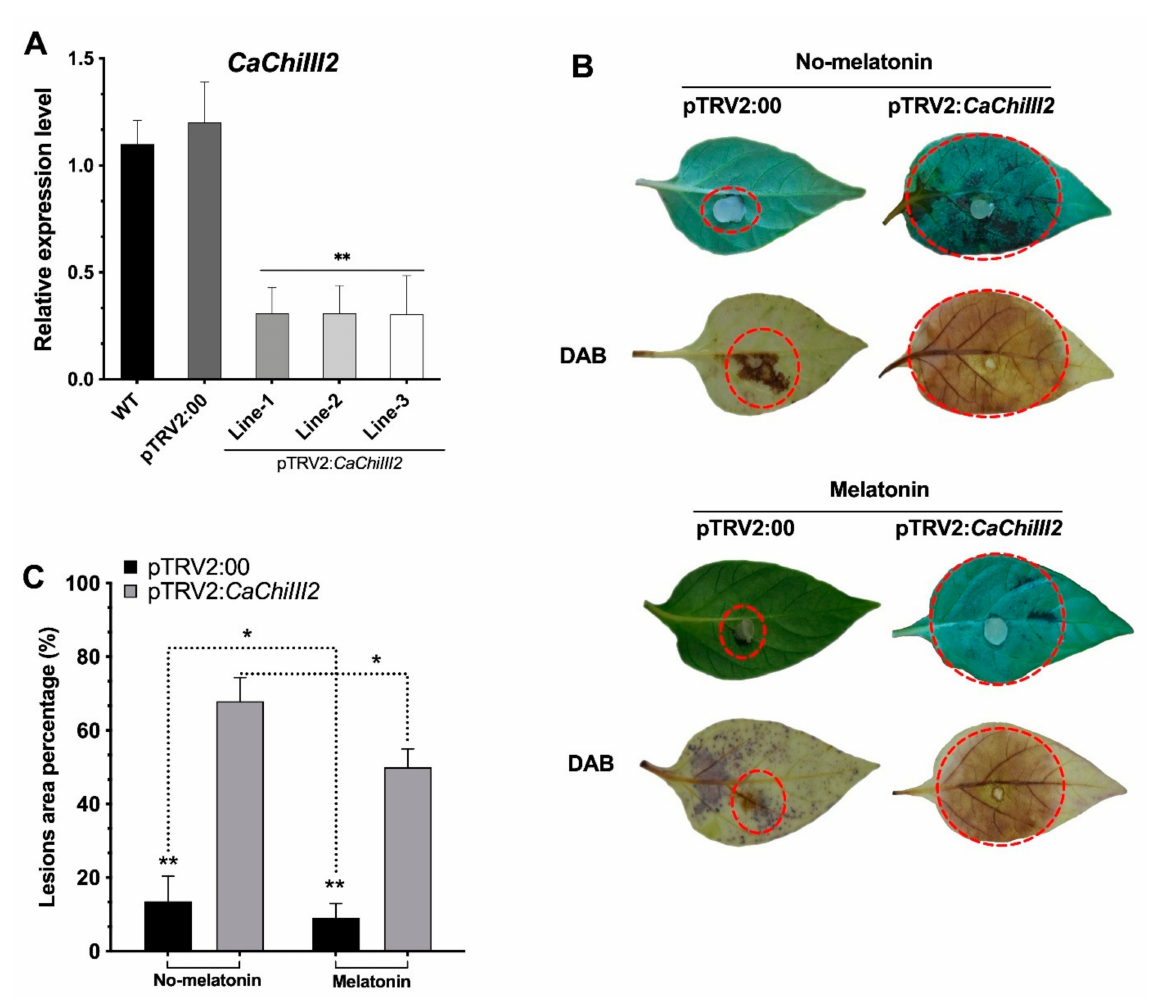
Figure 5. Silencing efficiency of CaChiIII2 and lesions area of detached leaves after the inoculation of C. gloeosporioides . ( A ) The relative expression level of CaChiIII2 in wild-type (WT), TRV2:00 and CaChiIII2 -silenced lines of pepper plants, ( B ) C. gloeosporioides infection symptoms appeared on leaves of TRV2: CaChiIII2 and TRV2:00 plant, H 2 O 2 detection with DAB (3,3-diaminobenzidine) staining, ( C ) Percent infection of C. gloeosporioides on pepper leaves in both groups (melatonin treated and untreated). The bars denote mean values ± SD of three individual replications, while asterisks on the bars denote differences among means at p ≤ 0.05 (*) and p ≤ 0.01 (**) according to the DMR